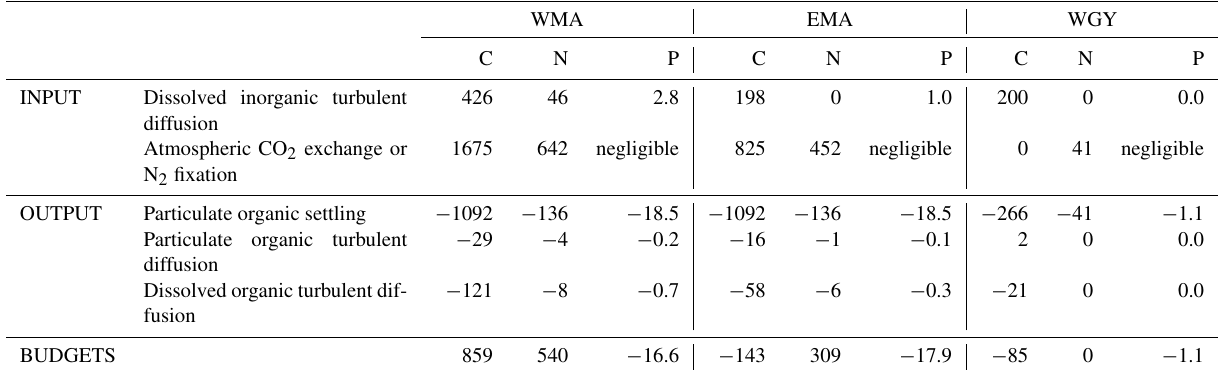
Table 6. The 0–70m upper layer comparative C, N, and P daily budgets in the three selected areas (western Melanesian Archipelago, WMA; eastern Melanesian Archipelago, EMA; and western gyre, WGY) sampled during the OUTPACE cruise (µmolm − 2 d − 1 )